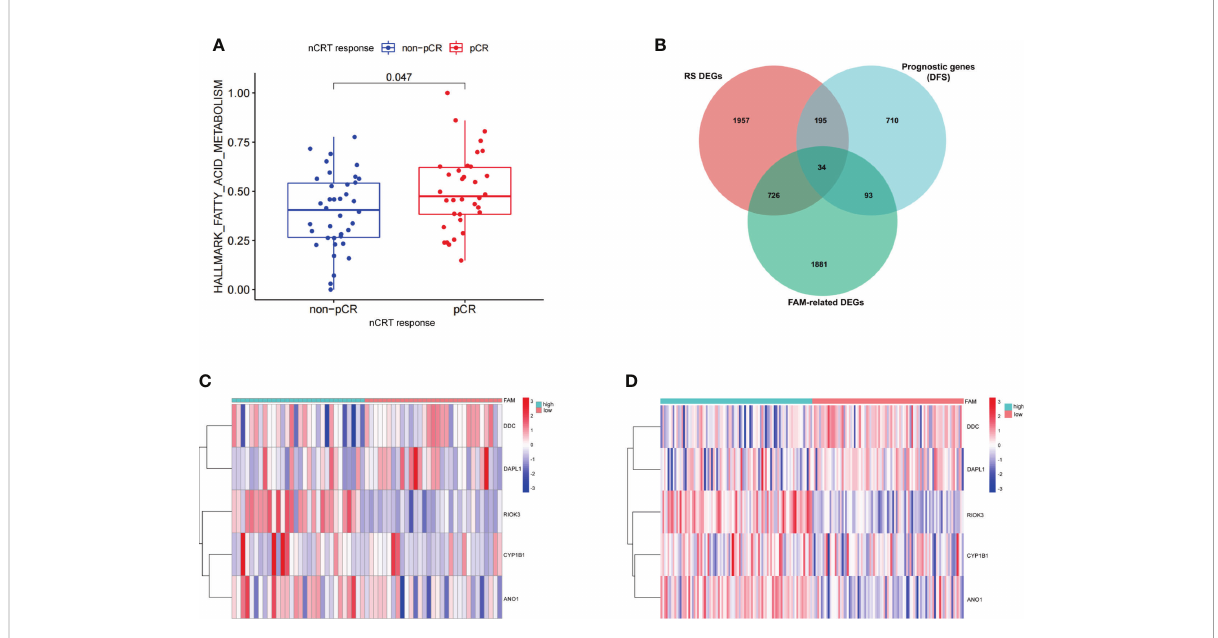
FIGURE 3 Construction of the FAM-related signature for patients with rectal cancer treated with neoadjuvant chemoradiotherapy. (A) The expression of FAM-related genes in relation to nCRT response. (B) Venn diagram identifying the intersection of genes among RS DEGs, FAM-related genes, and prognostic genes. (C, D) The expression levels of fi ve FAM score-related genes in GEO database (GSE56699 and GSE87211). nCRT, neoadjuvant chemoradiotherapy; RS, radiation sensitivity; DEGs, differentially expressed genes; FAM, fatty acid metabolism; LASSO, least absolute shrinkage and selection